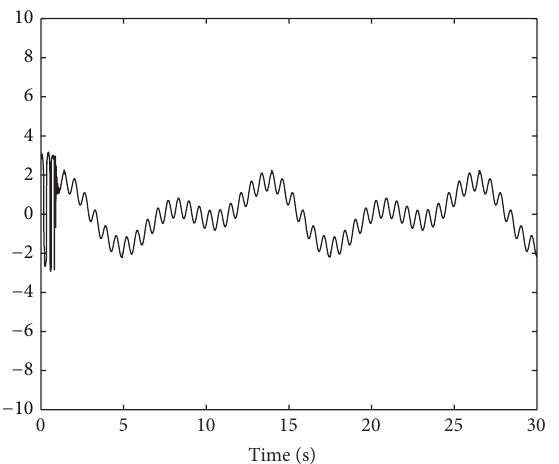
Figure 7: Trajectory of the system state 𝑥 2 .